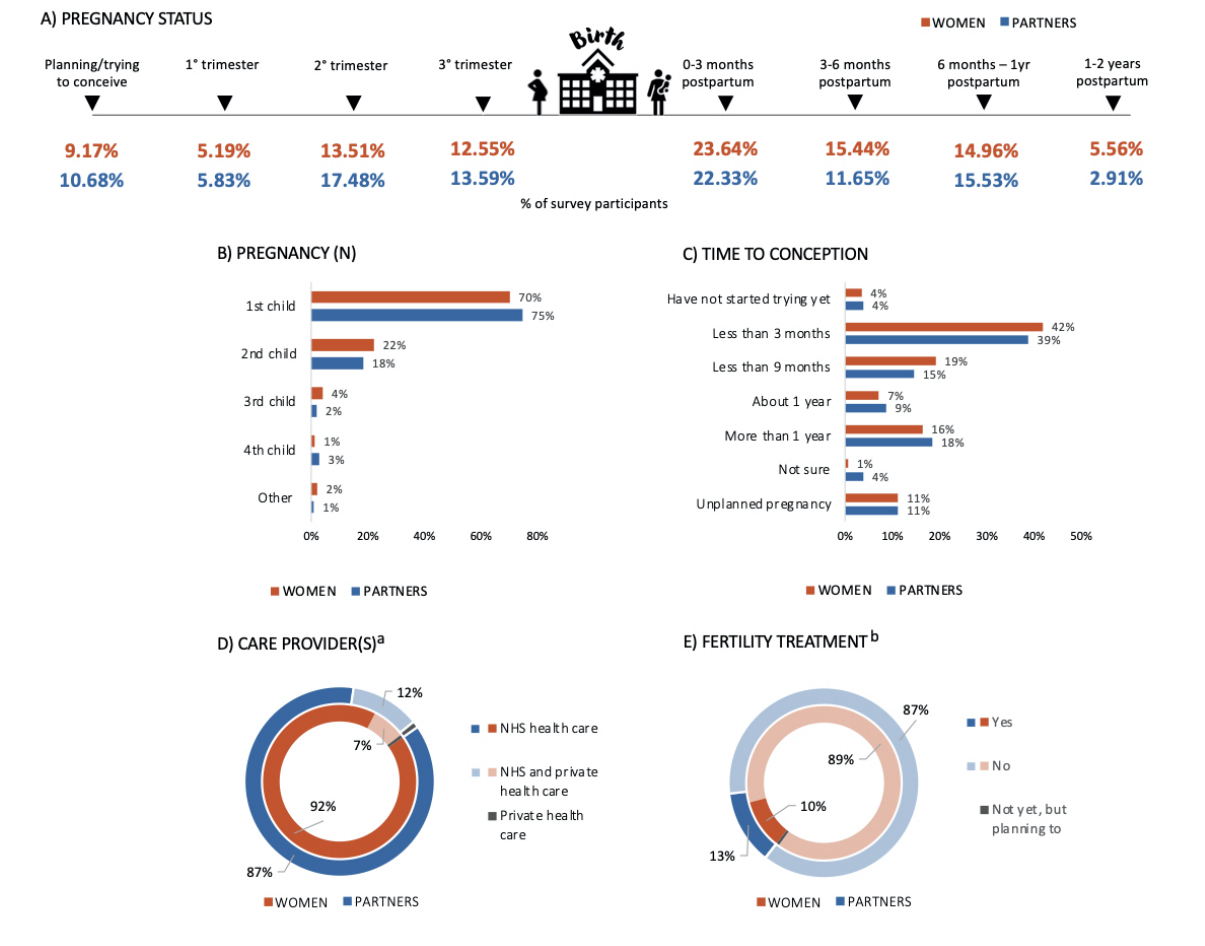
Figure 1. Perinatal health characteristics of women and partners, including pregnancy status (A), pregnancy number (B), time to conception (C), care provider(s) (D), and fertility treatment (E). a: Includes those in contact with the health care system (women: n=785; partners: n=93); b: Includes those who have started trying to conceive and planned pregnancies (women: n=707; partners: n=87). NHS: National Health